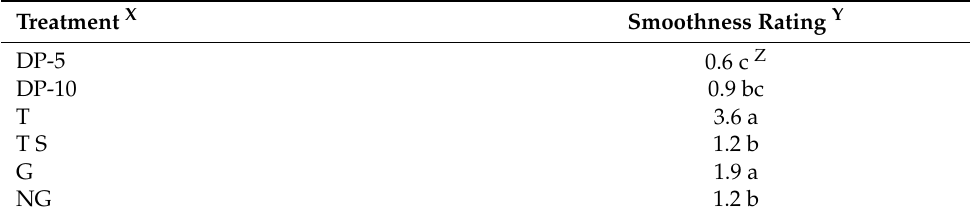
Table 5. Evaluation of smoothness in the 2016 Lawn Recovery trial. Treatment